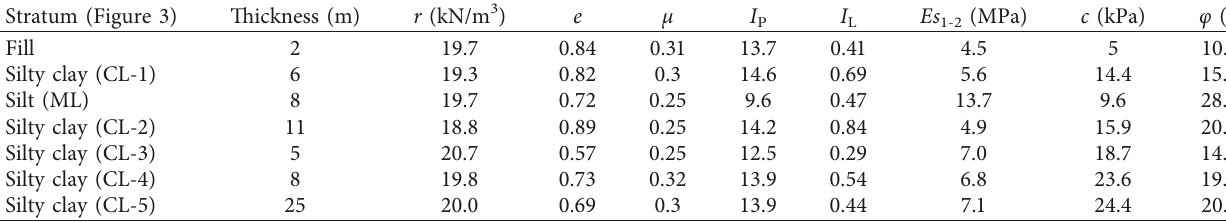
Table 2: Physical and mechanical properties of soil.